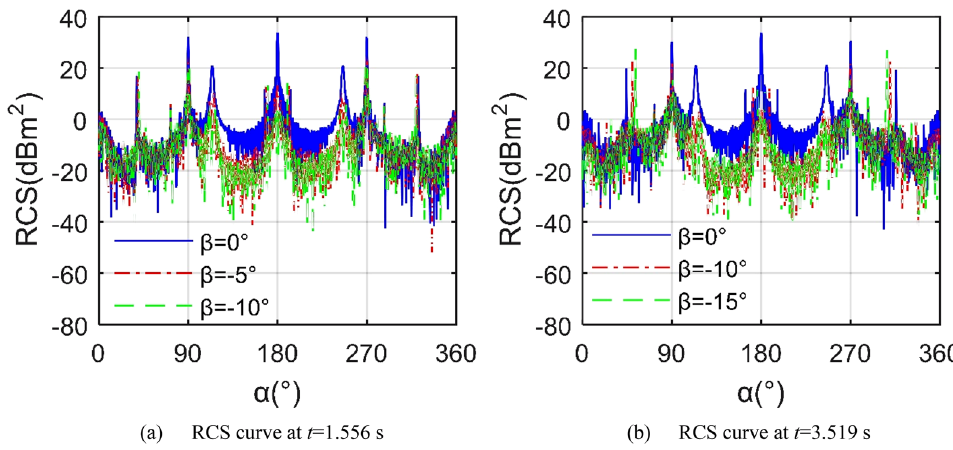
Figure 11. RCS of the aircraft under different elevation angle, f RH = 6 GHz, ω m1 = ω m2 = 0.1963 rad/s.